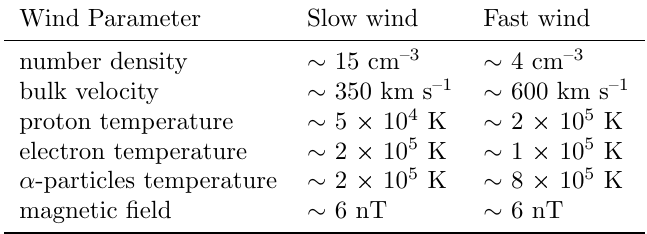
Table 6: Typical values of several solar wind parameters as measured by Helios 2 at 1 AU.